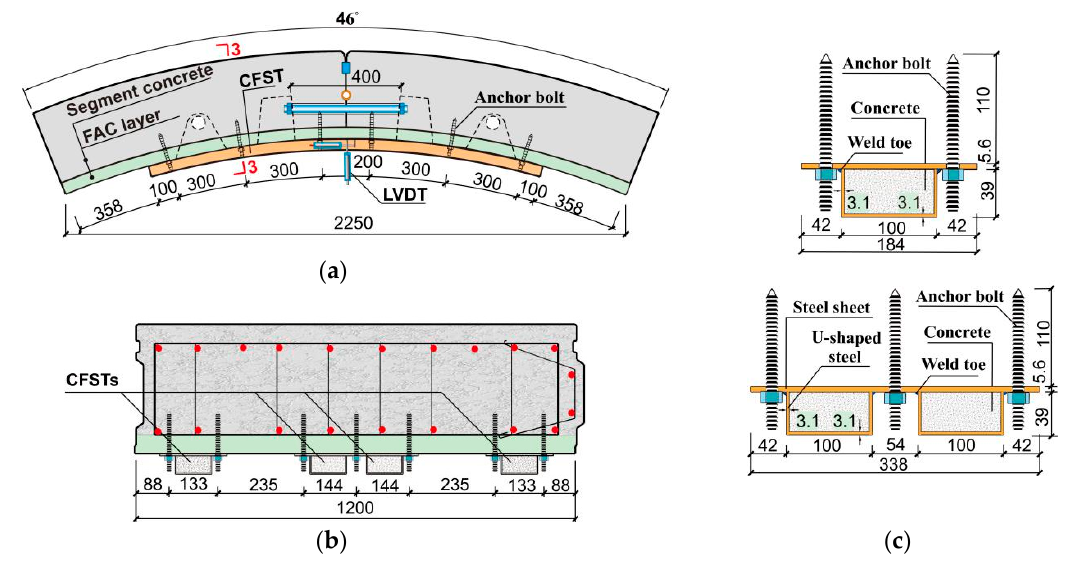
Figure 2. The repair and strengthening process comprised three steps: